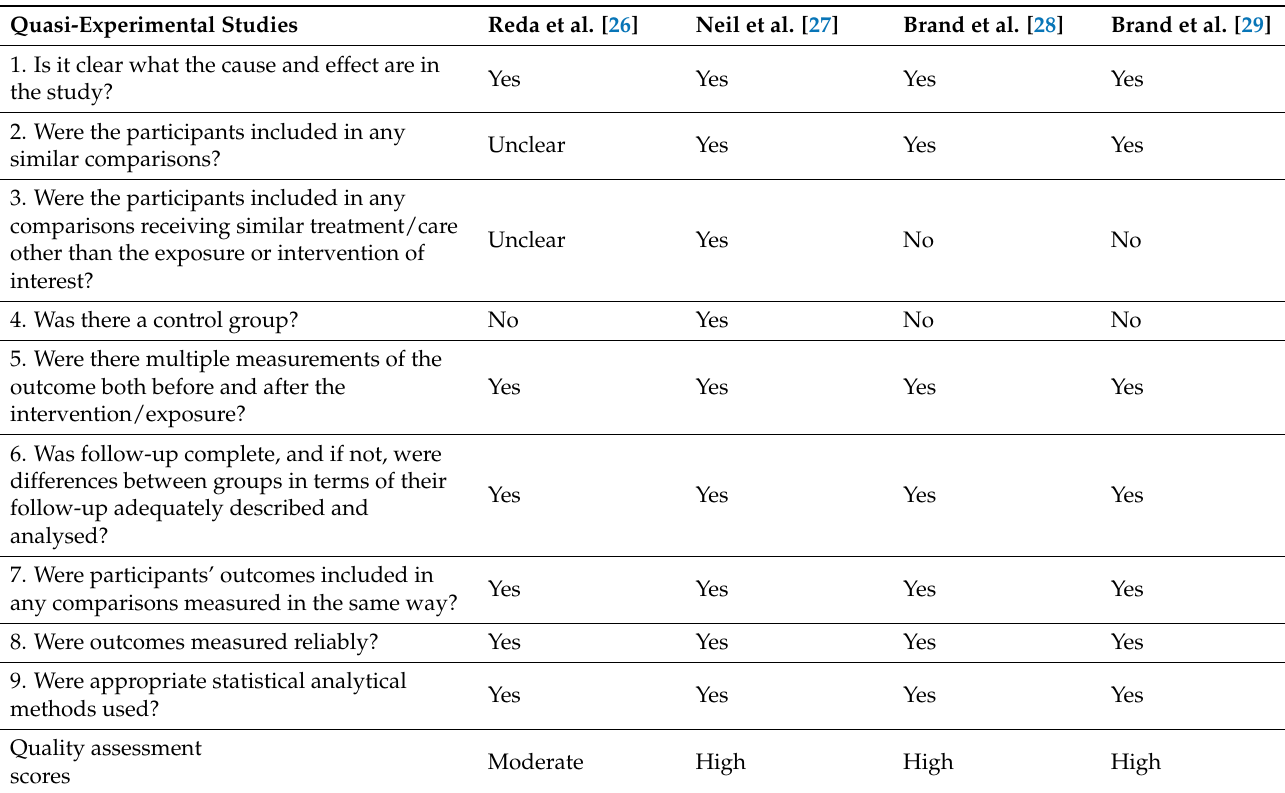
Table A2. A quality appraisal of the included studies using